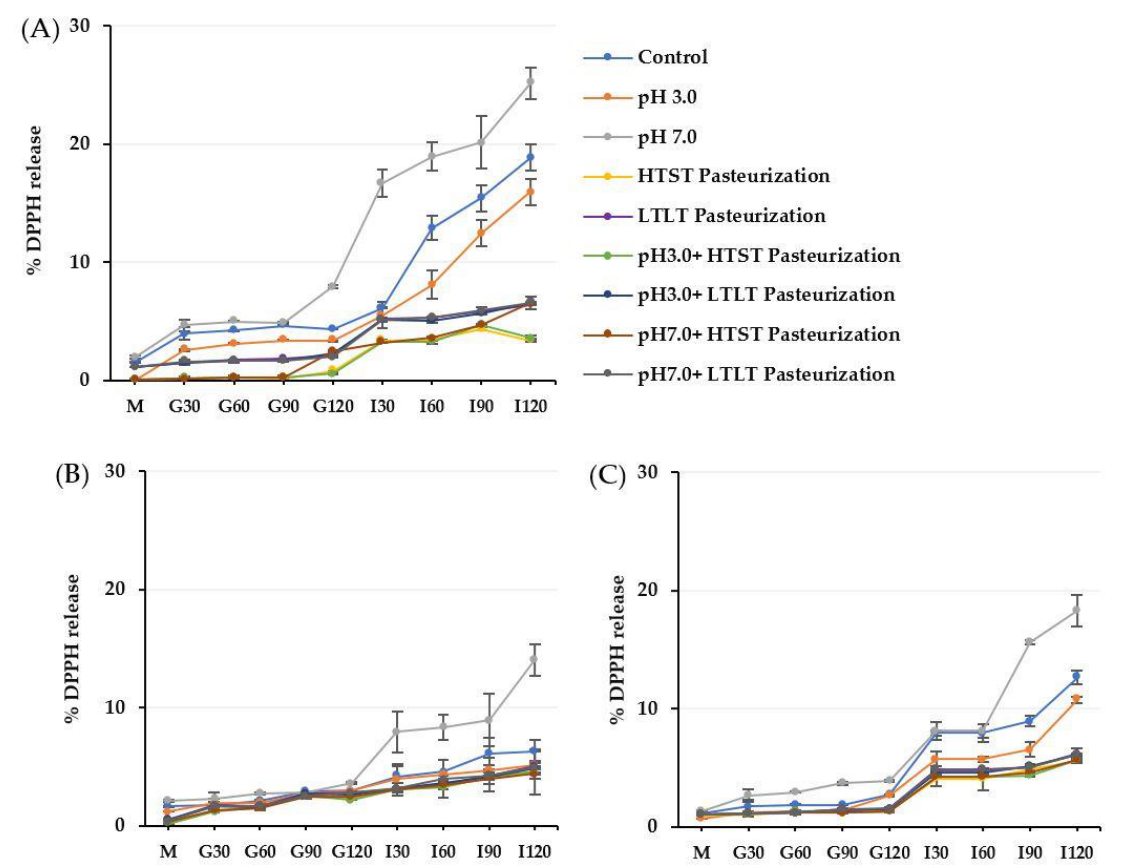
Figure 5. % DPPH release of alginate ( A ), alginate/maltodextrin ( B ), and alginate/inulin ( C ) hydrogel beads in simulated gastrointestinal fluid. M = simulated oral phase, G30–G120 = simulated gastric phases at 30, 60, 90, and 120 min, respectively, I30–I120 = simulated intestinal phases at 30, 60, 90, and 120 min, respectively. The error bars indicate the SD of the data.